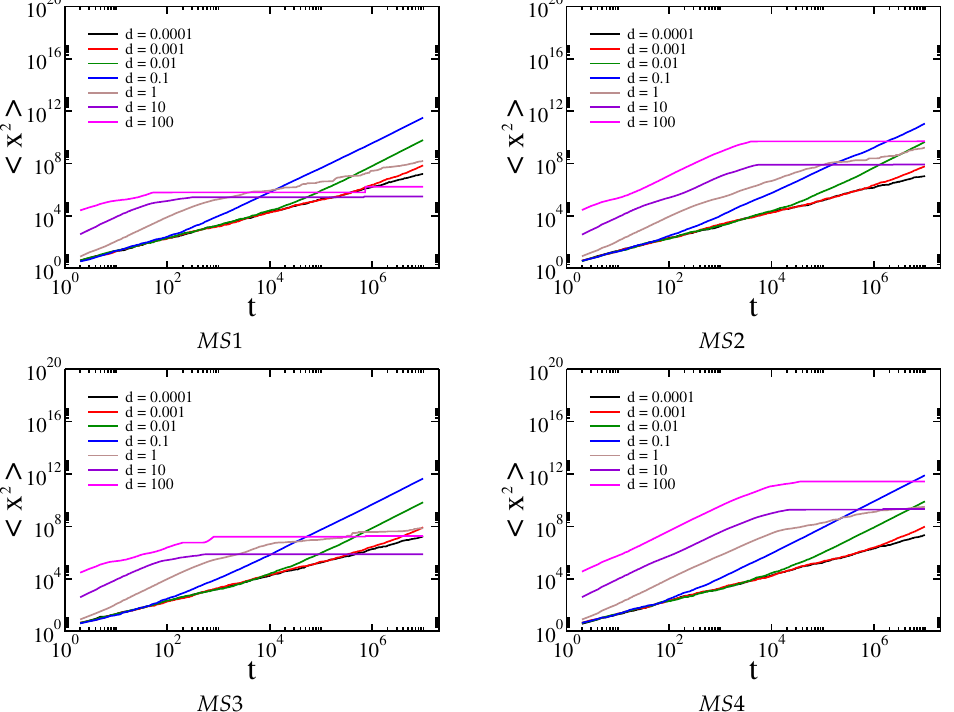
Figure 6. Dependence of the mean square displacement x 2 on time driven by Gaussian random walk in the structures MS1, MS2, MS3, and MS4,